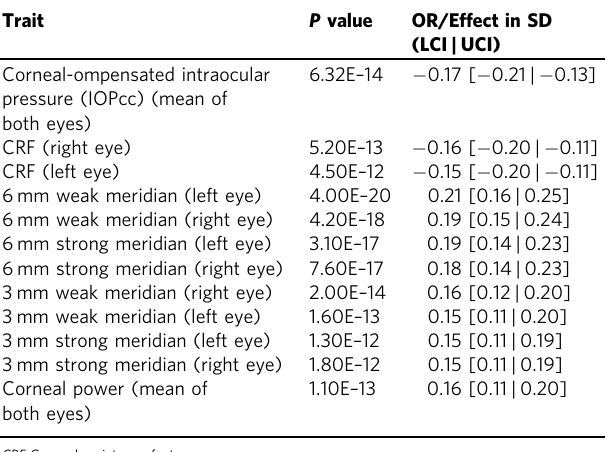
Table 1 Statistically signi fi cant ( P < 2 × 10 − 6 ) results from PheWAS of an aggregate of up to 110 pLOF and deleterious missense variants (MAF < 1%) in ANGPTL7 in